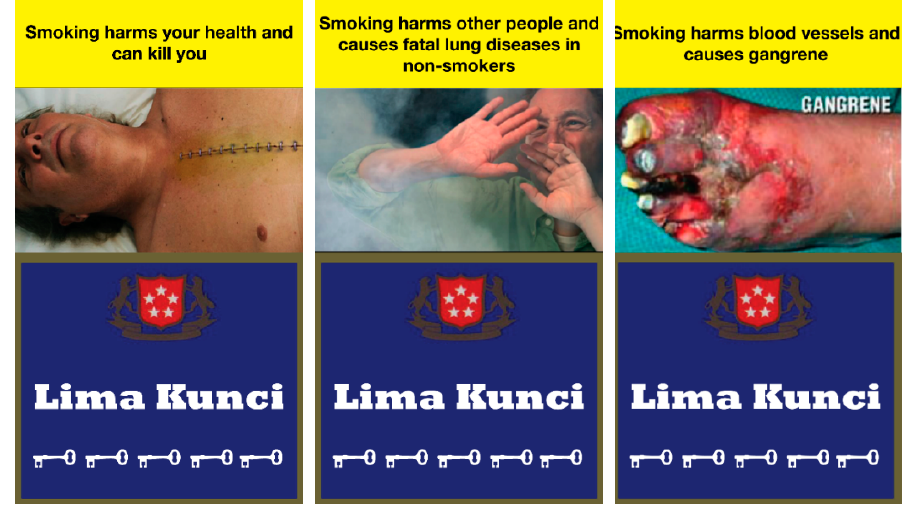
Figure 2. Nonreligious Health Warning Labels.